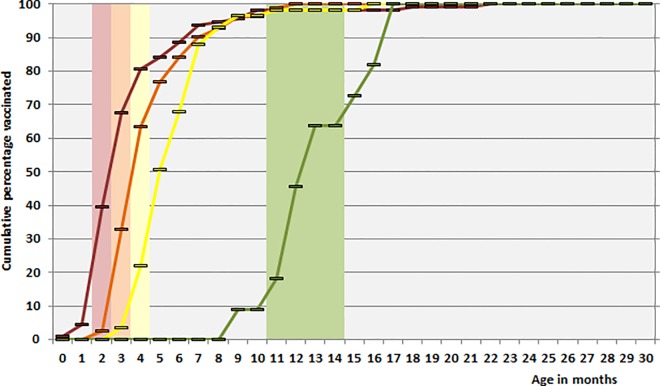
Timeliness of pneumococcal conjugate vaccination (PCV7) of children under two years of age with IPD in Germany (July 2006 –June 2010).Bars indicate scheduled vaccination times, lines indicate cumulative actual vaccination rates in percentage (red: 1st dose, orange: 2nd dose, yellow: 3rd dose, green: booster dose). Only doses given before the time of infection were taken into consideration.